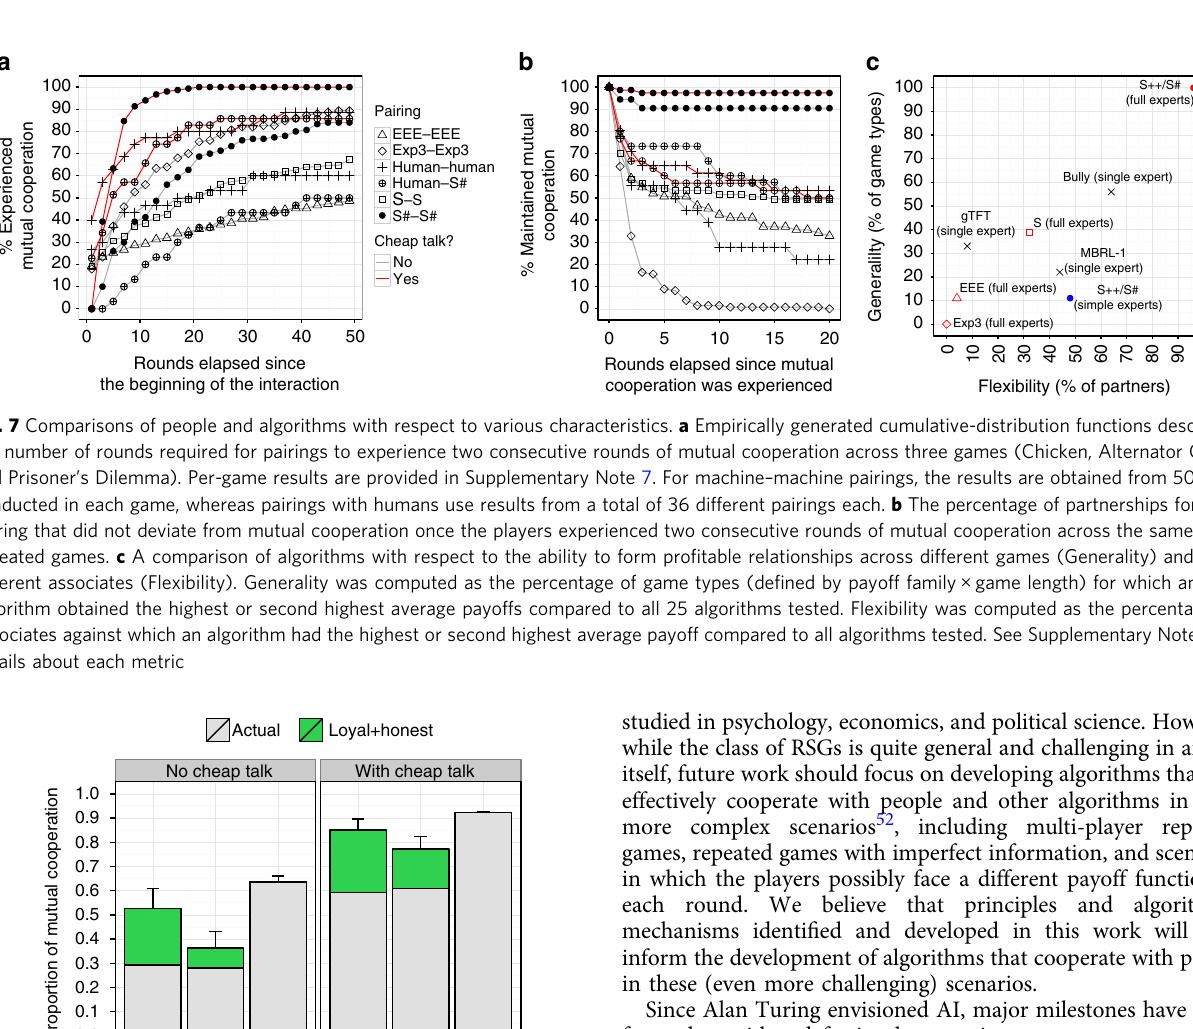
games from the periodic table of games (Supplementary Note 2).